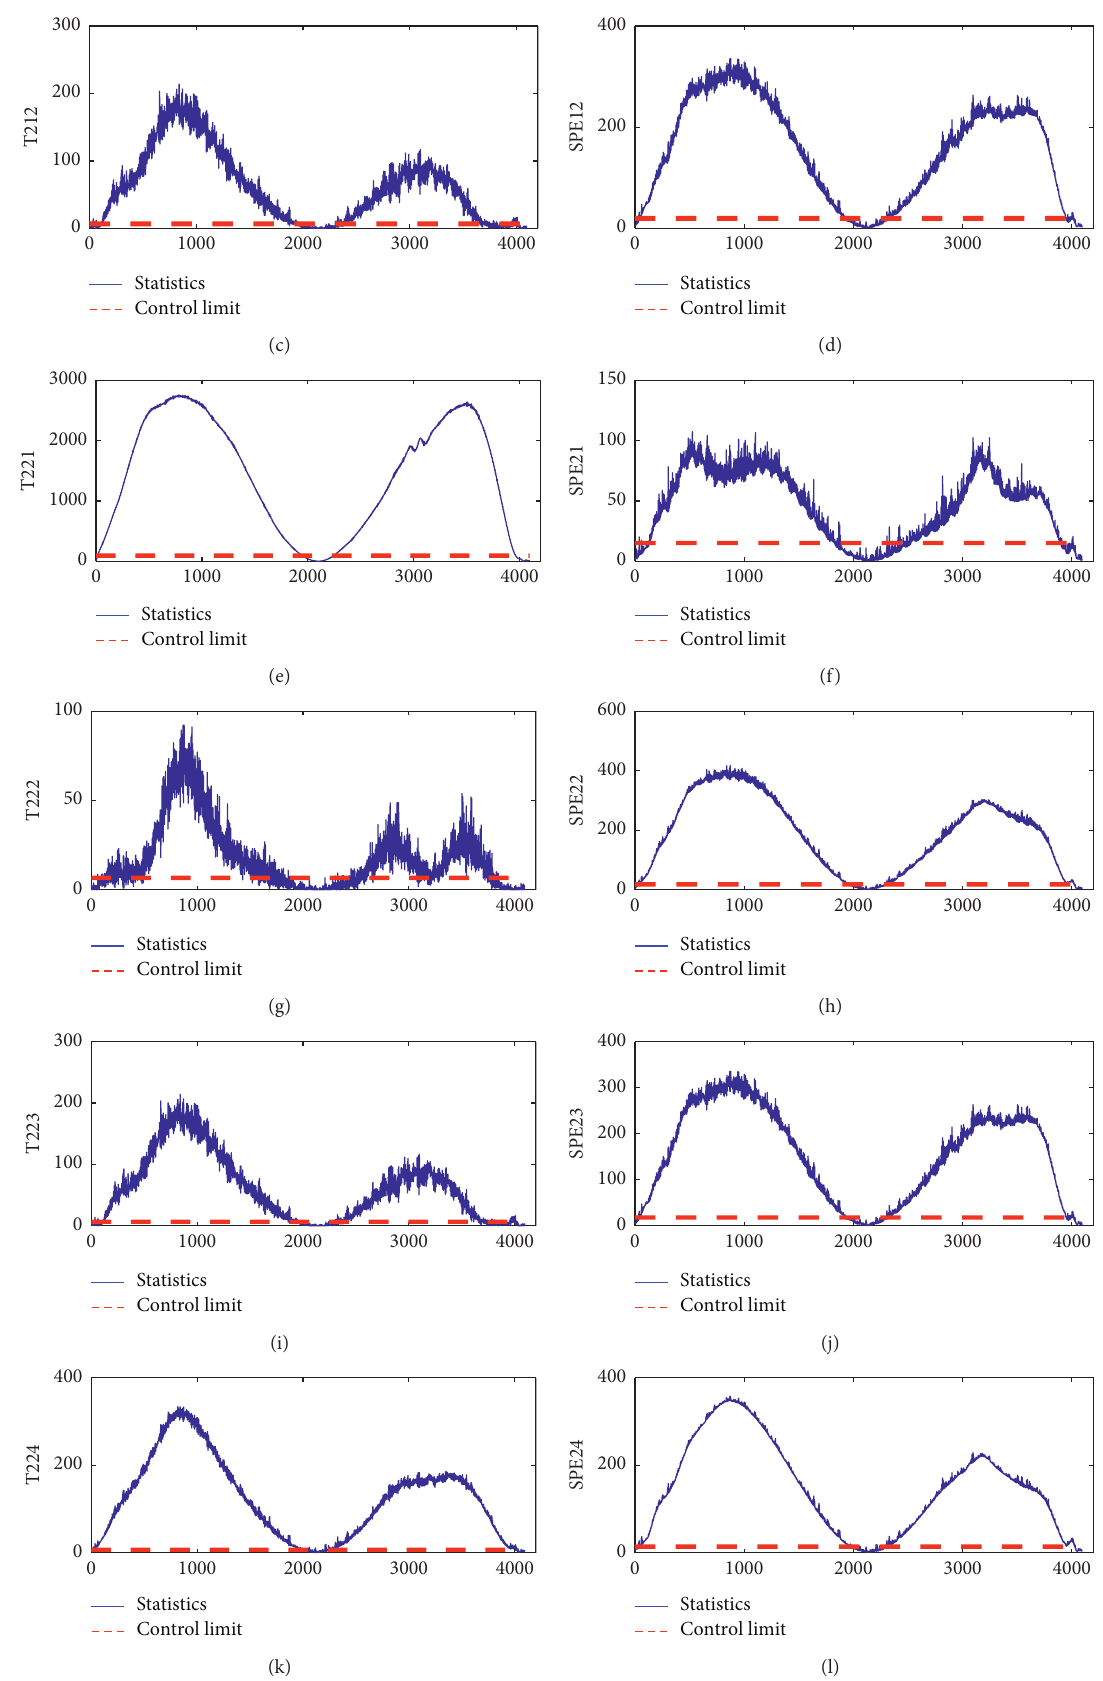
Figure 13: Mechanical failure comprehensive simulation experiment bearing outer ring failure results based on Deep